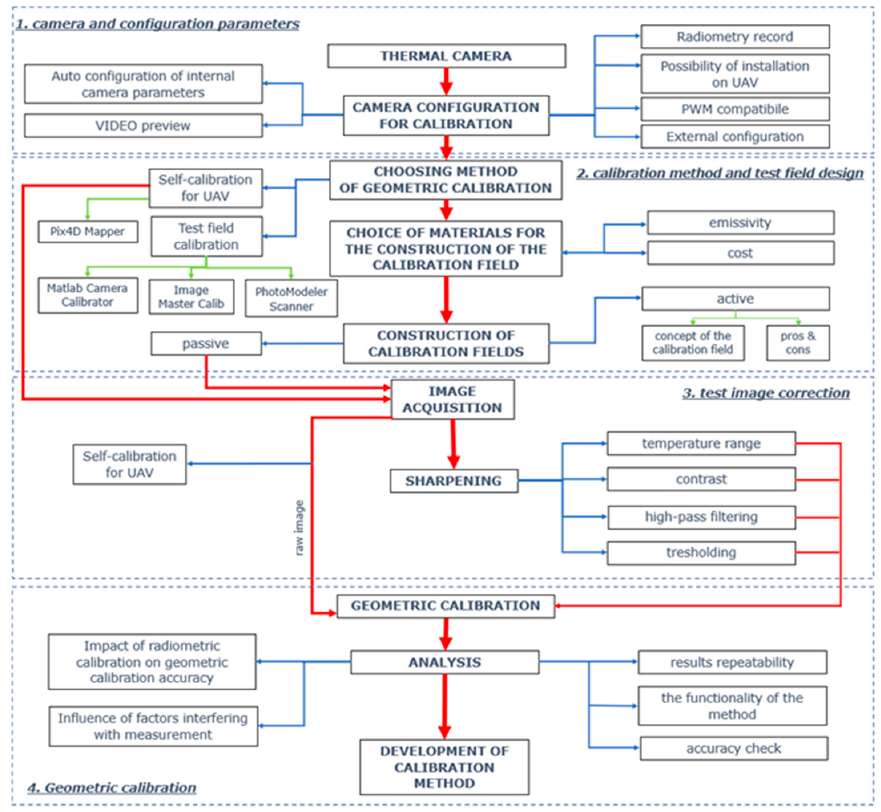
Figure 8. Overview of the proposed methodology.